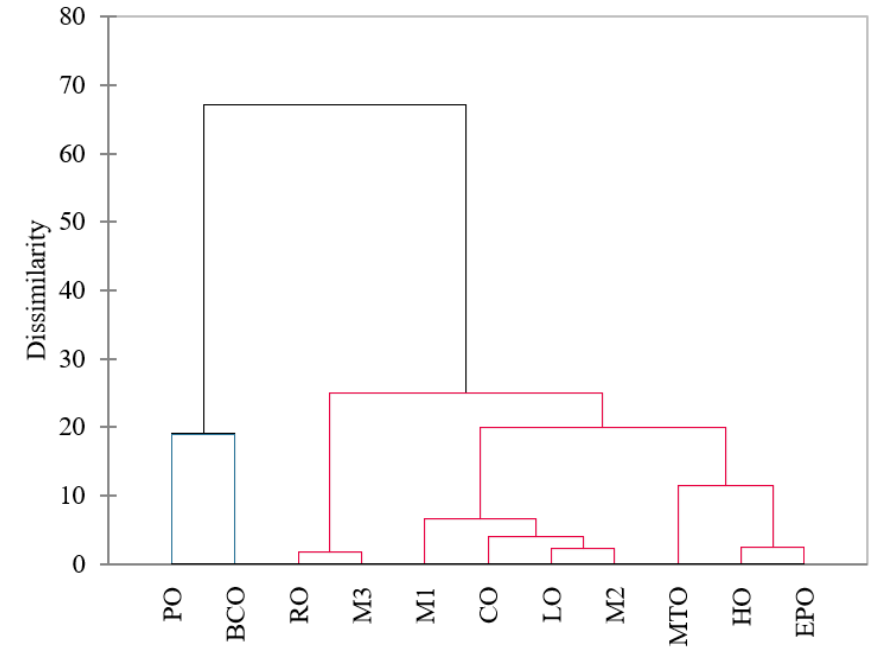
Figure 2. Agglomerative Hierarchical Clustering (AHC) for analysed oils.